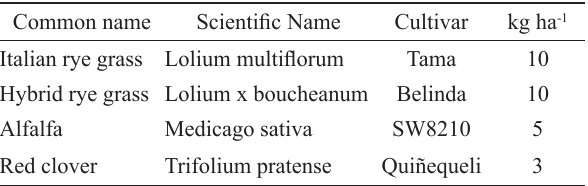
Table 2. Treatments evaluated in this study Treatments Description Mixed pasture establishment with manual weeding T without pea. 1 Mixed pasture establishment without weeding nor T pea 2 Mixed pasture establishment, with pea, without T 3